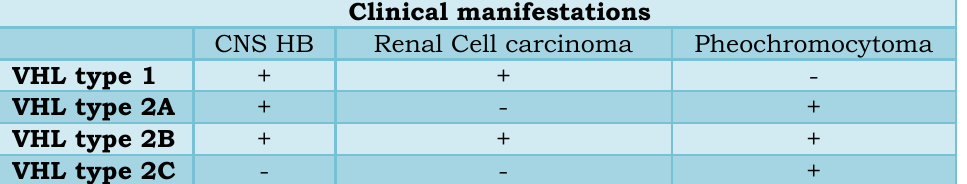
Table 1. Clinical classifications and manifestations of VHL disease Clinical manifestations CNS HB Renal Cell carcinoma